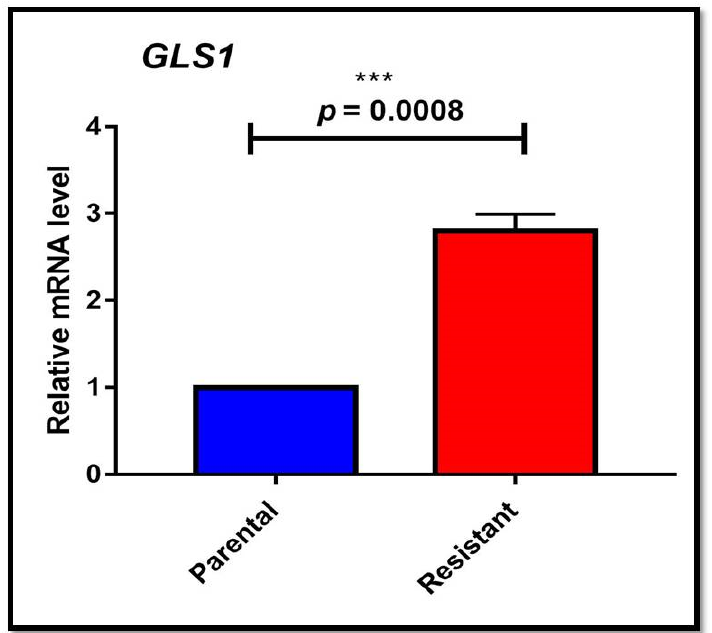
Figure 3. GLS1 (glutaminase) expression analysis in parental and sorafenib resistant HepG2 cells (*** p ≤ 0.001) .